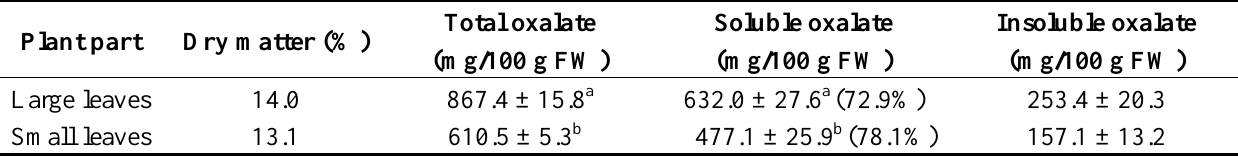
Values with a different superscript for the large and small leaves are significantly different ( p < 0.05). Table 3. The oxalate contents in raw and cooked leaves stems and buds of Good-King-Henry samples (mg/100 g FM ± SE). Values in brackets are % soluble oxalate of total oxalate. Treatment